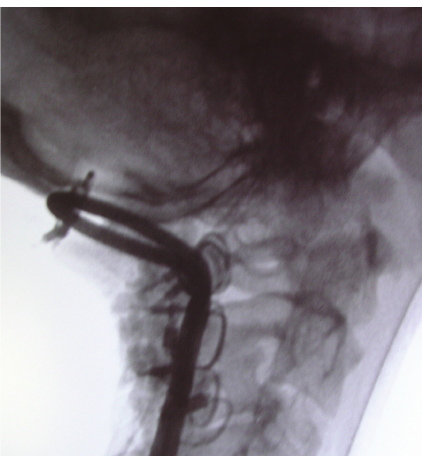
Figure 3: Immediate postoperative radiographs showing the occip- itocervical fusion.